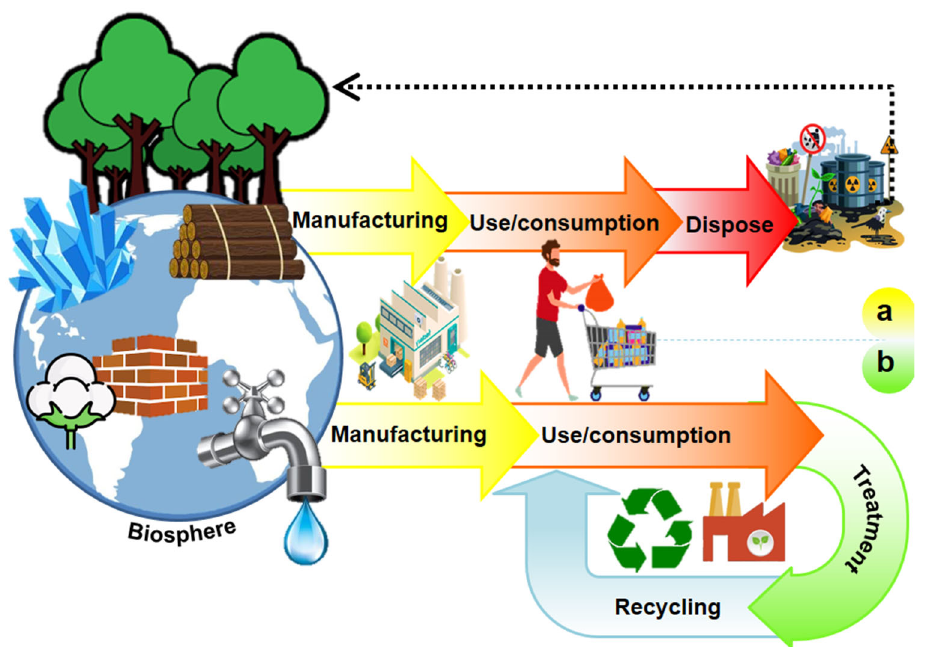
Figure 2. Economic models: ( a ) linear economy and ( b ) circular economy. Water Circular Economy